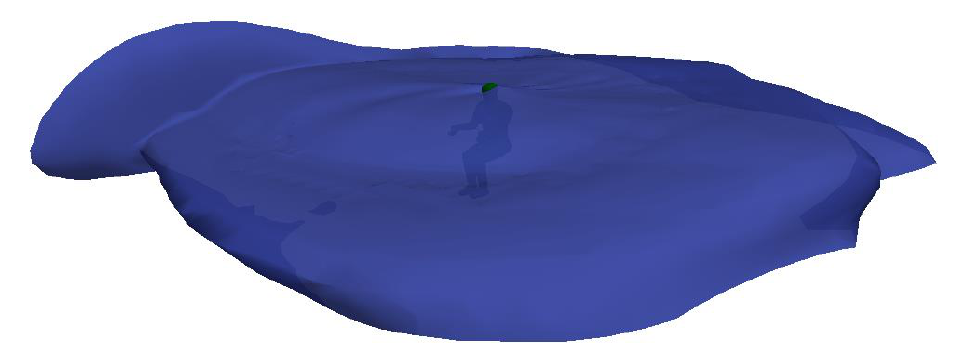
Figure A8. Simulated distribution. Isosurface using concentration envelope of 1 µ g/m 3 for device Figure B2. Simulated distribution. Isosurface using concentration envelope of 1 µg/m 3 for device mass rate of 6.444 µ g/s. mass rate of 6.444 µg/s.